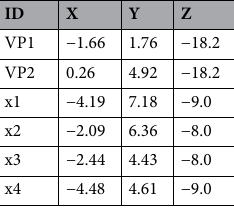
Table 2. Positions of the detectors and coordinates of reference points in the reference system used in the paper (in